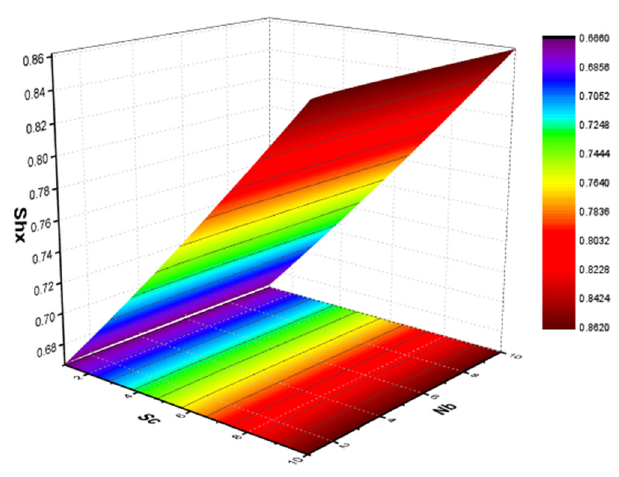
Nu Nb Nt and on x . Nu Nb Nt and on x .